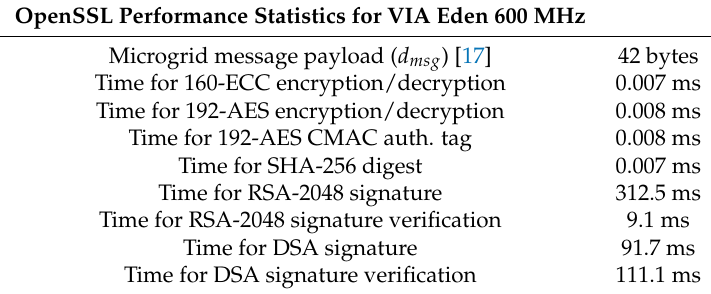
Table 2. Security Algorithm Time Performance